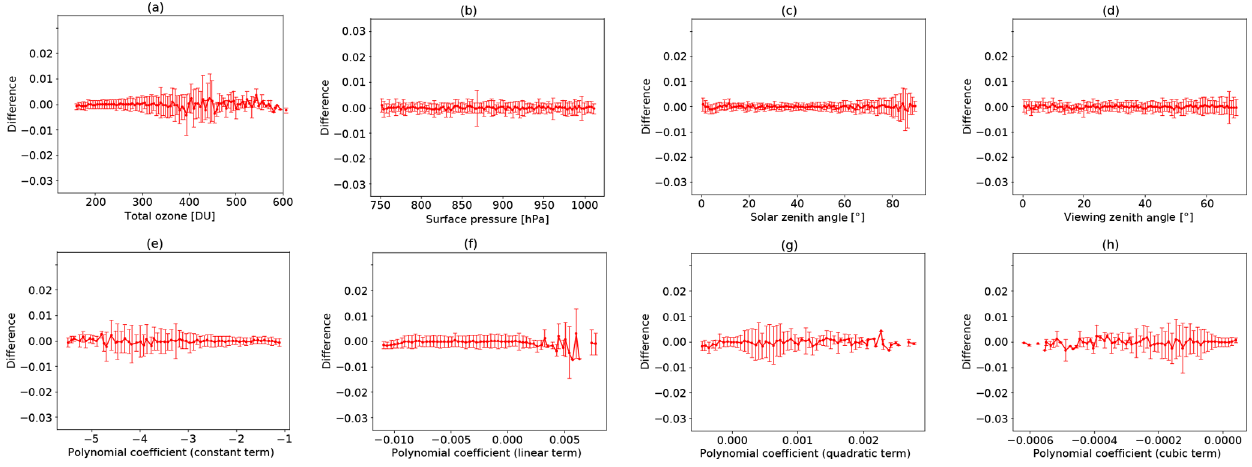
Figure 5. GE_LER retrieval error as a function of (a) total ozone, (b) surface pressure, (c) solar zenith angle, (d) viewing zenith angle, and ( e to h ) the four DOAS polynomial fitting coefficients.